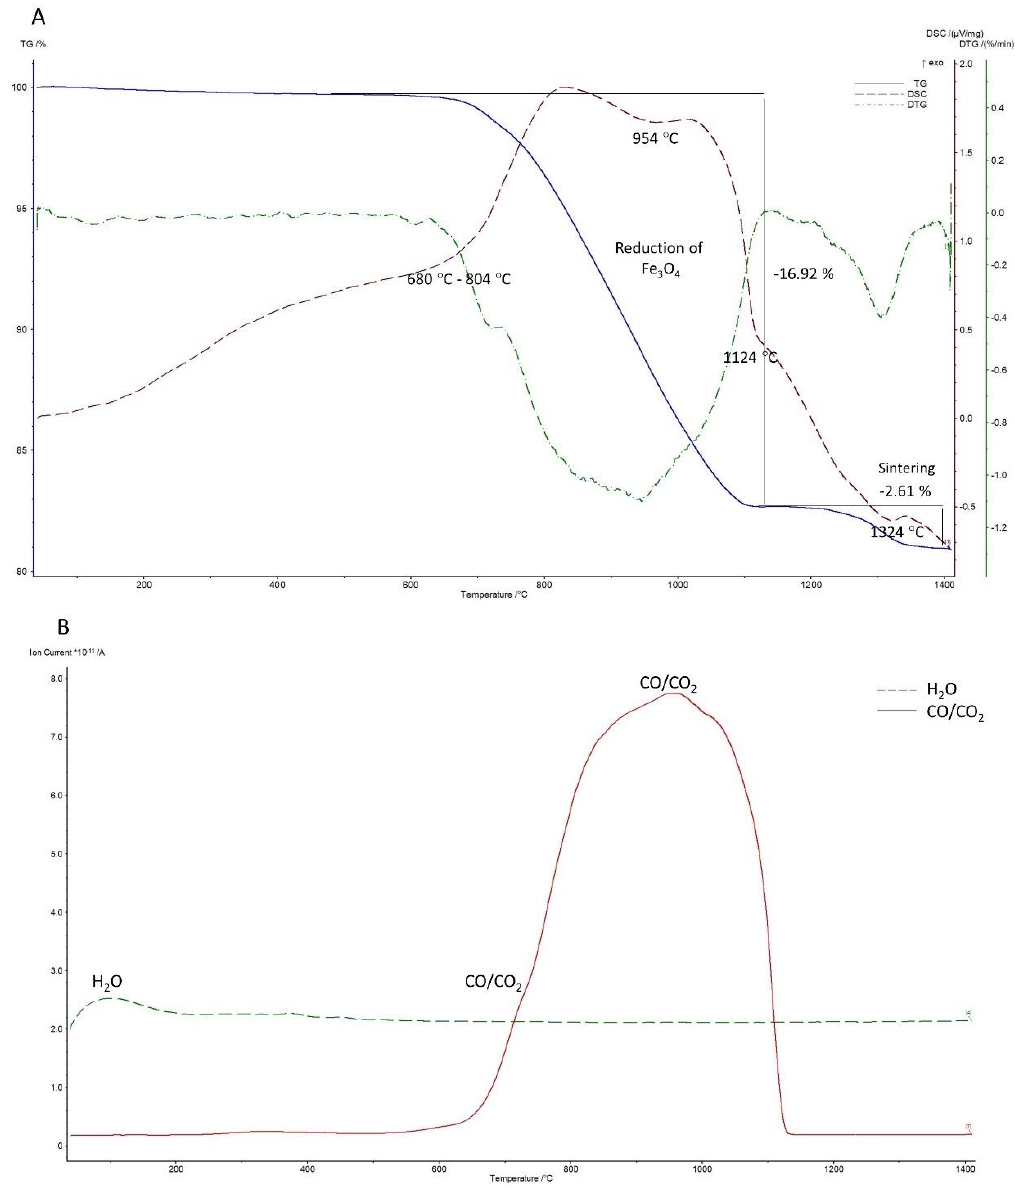
Figure 4. Thermal analysis of BF sludge under argon atmosphere: ( A ) TG/DTA/DTG; ( B ) Mass spectroscopy.